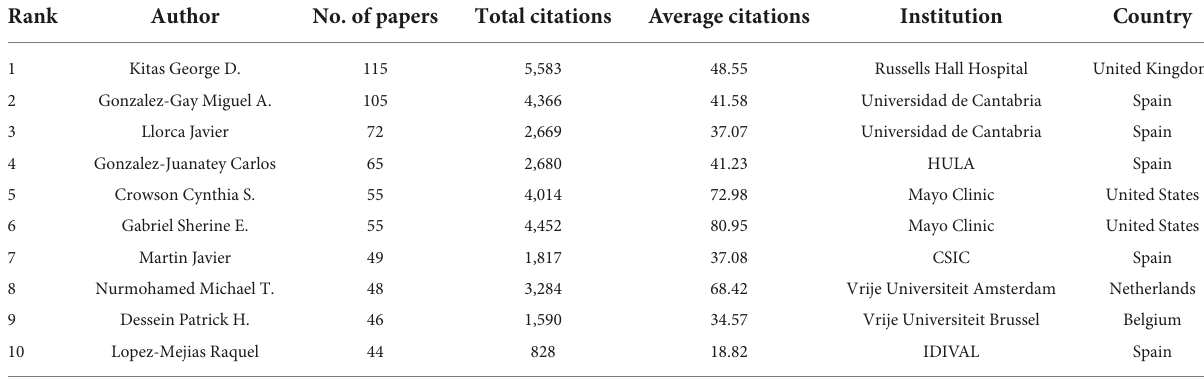
TABLE 3 Top 10 most prolific authors on rheumatoid arthritis-related cardiovascular disease.